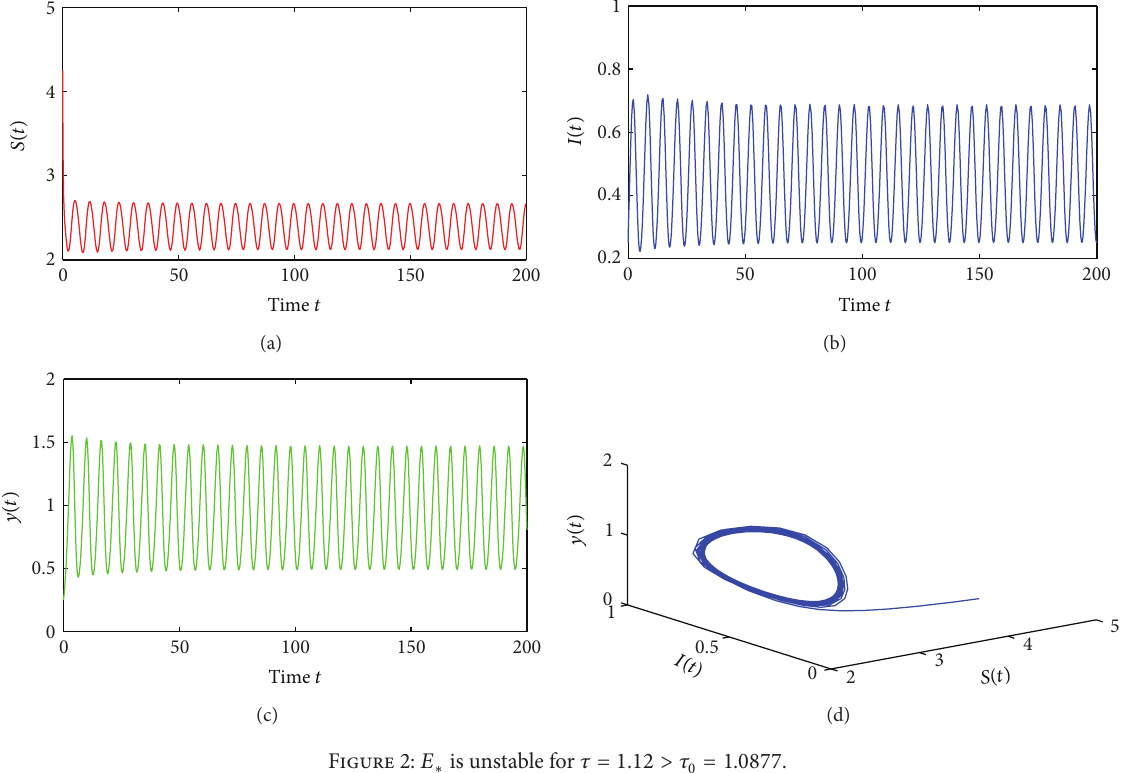
Figure 2: 𝐸 ∗ is unstable for 𝜏 = 1.12 > 𝜏 0 = 1.0877 .